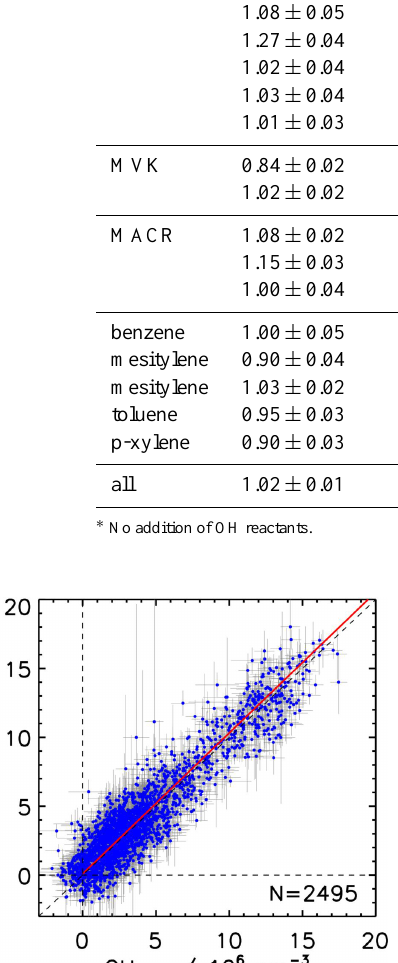
Table 3. Linear correlation (correlation coefficient R 2 ) and regression analysis (LIF vs. DOAS) of data (time resolution of DOAS data, number of data points N ) for each experiment and the entire data set. Errors of the fit parameters are 1 σ errors. χ residuals divided by the degrees of freedom ( N − 2).